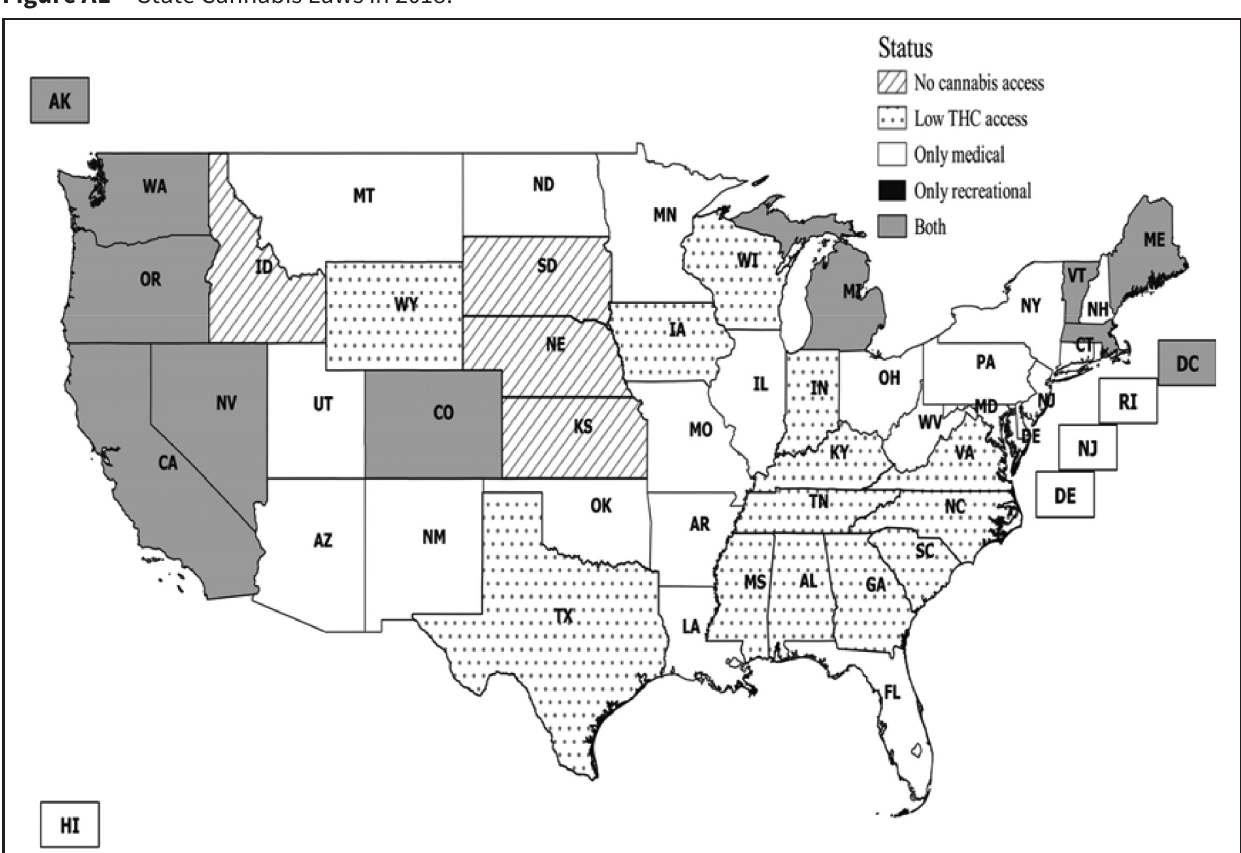
State Cannabis Laws in